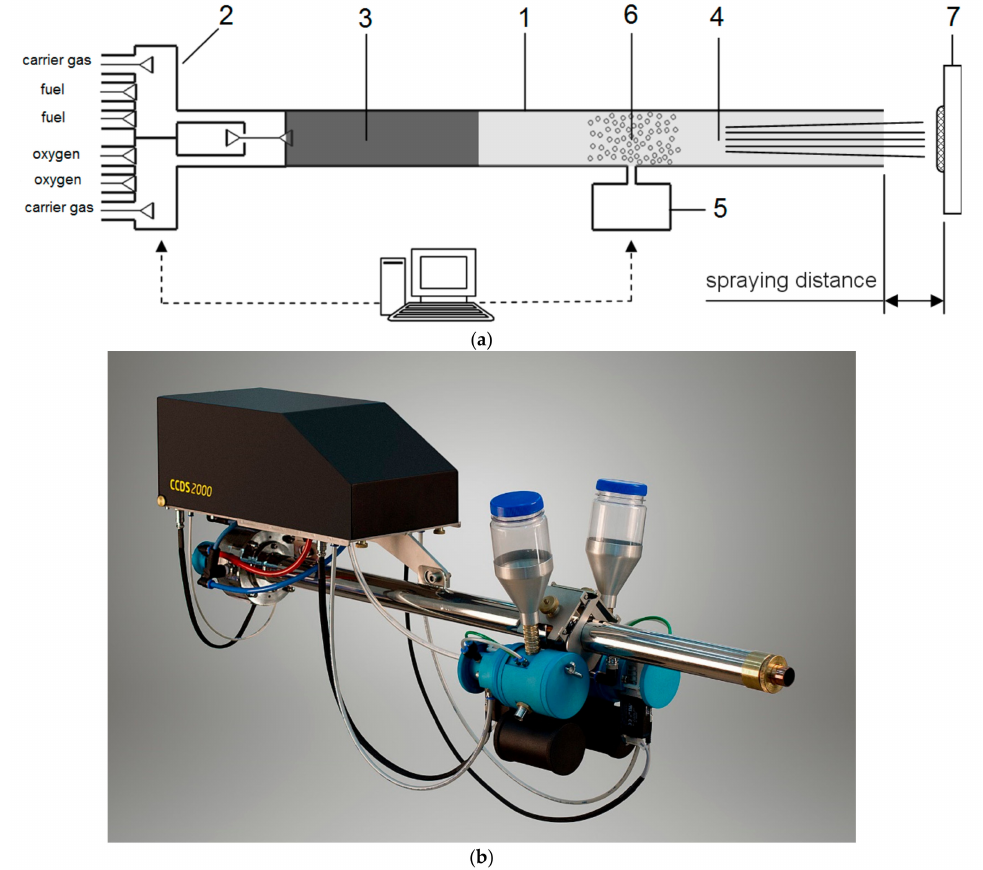
Figure 1. ( a ) A schematic of a CCDS2000 facility: 1—gun barrel, 2—computer-controlled precision gas distribution system, 3—explosive charge, 4—carrier gas, 5—computer-controlled powder feeder, 6—cloud of injected powder and 7—substrate [21] and ( b ) a general view of the detonation gun of a computer-controlled detonation spraying (CCDS)